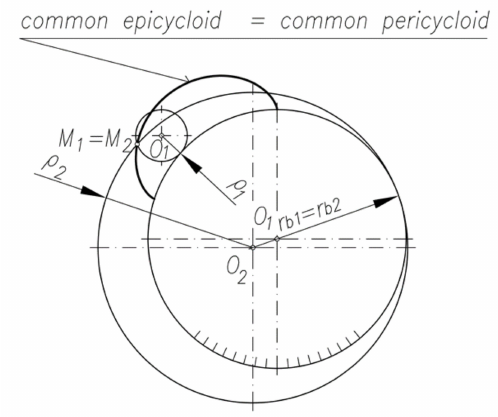
Figure 3. Equivalence of the common epicycloid (index 1) and the common pericycloid (index 2). In the literature [32–34], the term also used is “trochoid”, which, according to the mathematical Equation (30), refers to the extended or shortened cycloidal curves. Trochoids do not refer to the common